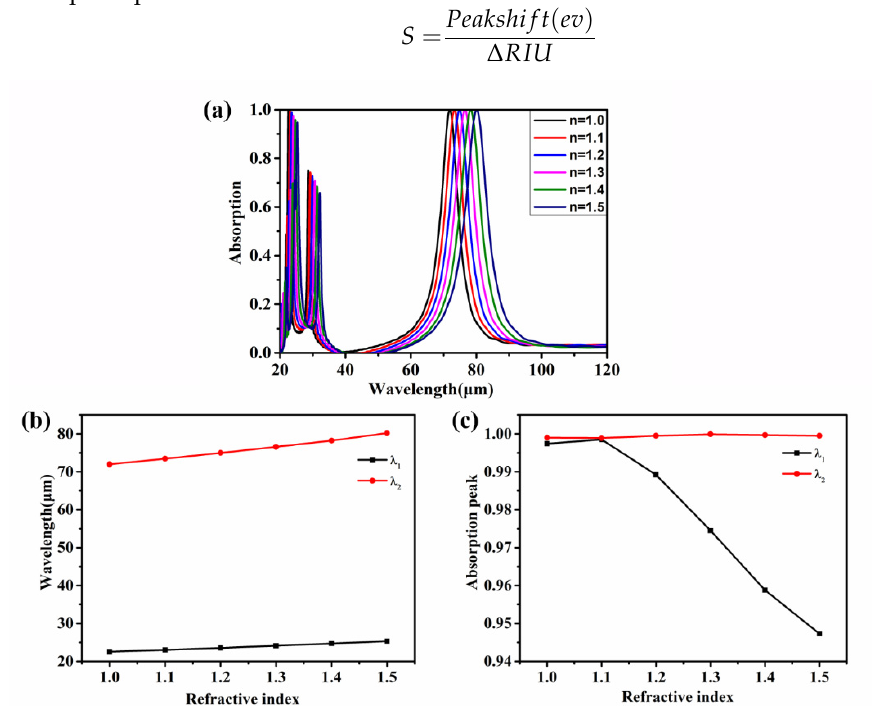
Figure 7. ( a ) Absorption spectra under different background refractive indices. ( b ) The function relationship between the wavelengths of two perfect absorption peaks and the background refractive index. ( c ) The relationship between the absorption rate of two perfect absorption peaks and the background refractive index.